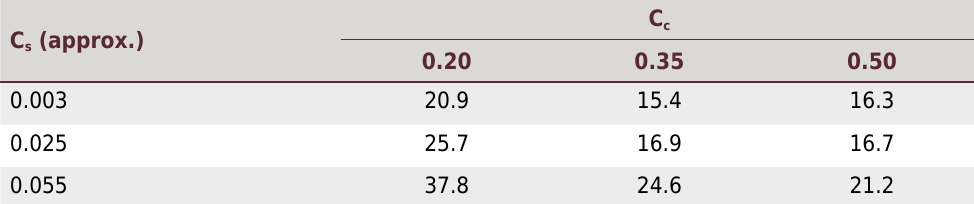
Table 1. Coefficient of variation for the simulated means of the seven methods in each scenario defined by C c and C s C s